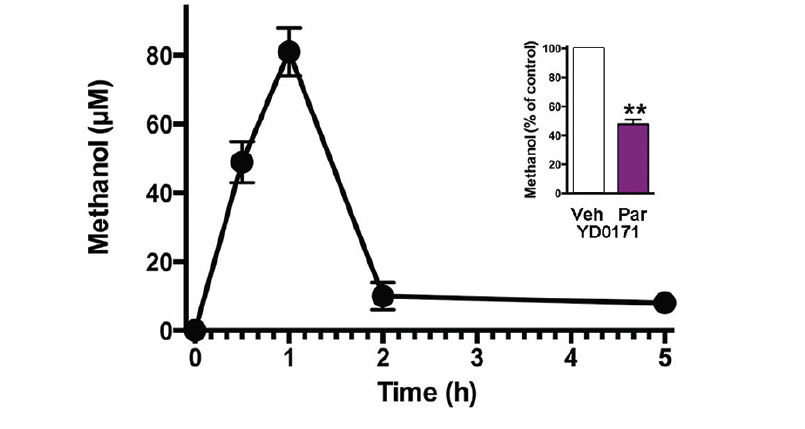
Figure 4. Methanol production in response to YD0171 in HCT116 cells. In response to YD0171 (1 mmol/L), the generation of methanol was noted in the HCT116 cells, with a peak at 1 h postexposure. Inset shows ethanol production in the presence of 1 mmol/L YD0171 at 2 h in the absence or presence of 1 mmol/L paraoxon pretreatment; ** p < 0.01. Data shown as mean ± SEM; n = 3.